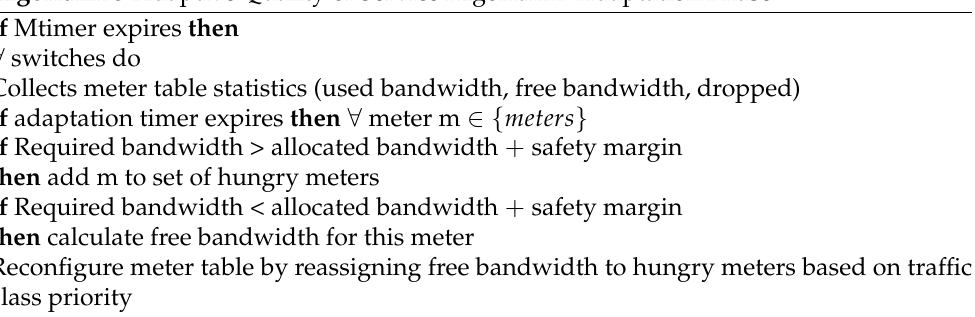
Algorithm 3 Adaptive Quality of Service Algorithm: Adaptation